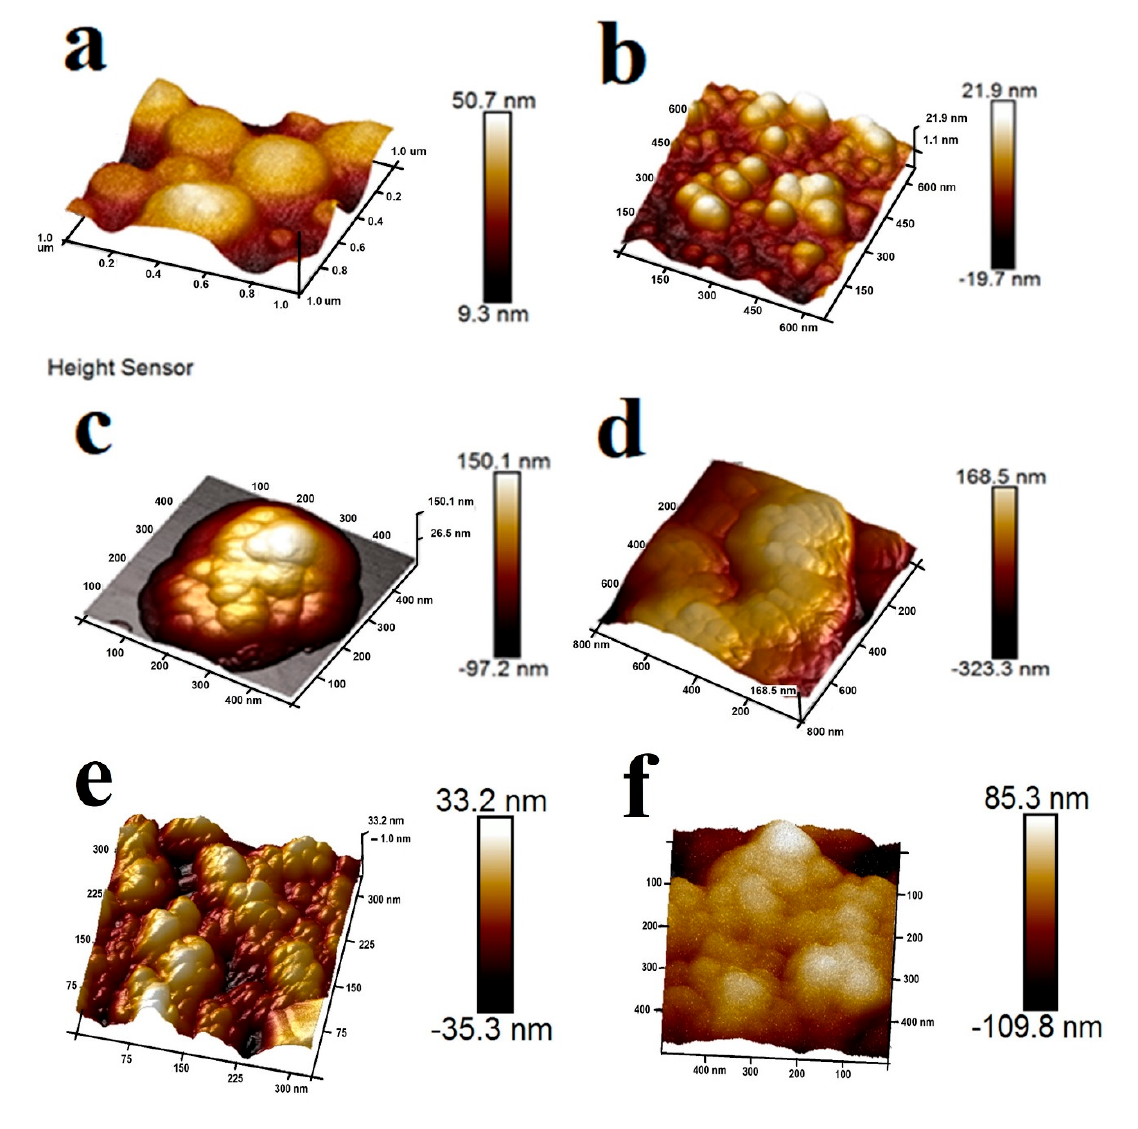
Figure 3. AFM images of native HRP ( a ) and LiP ( b ) enzymes and sol–gel encapsulated HRP ( c ) and LiP ( d ) composites and initial magnetite ( e ) and silica coated magnetite ( f ).